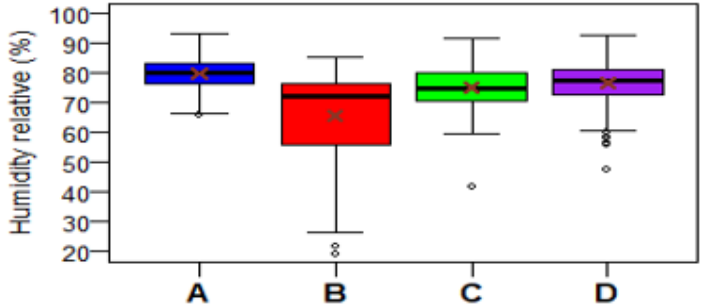
Atmosphere 2020 , 11 , x FOR PEER REVIEW Figure 8. Relative humidity associated with each cluster at the receptor position.